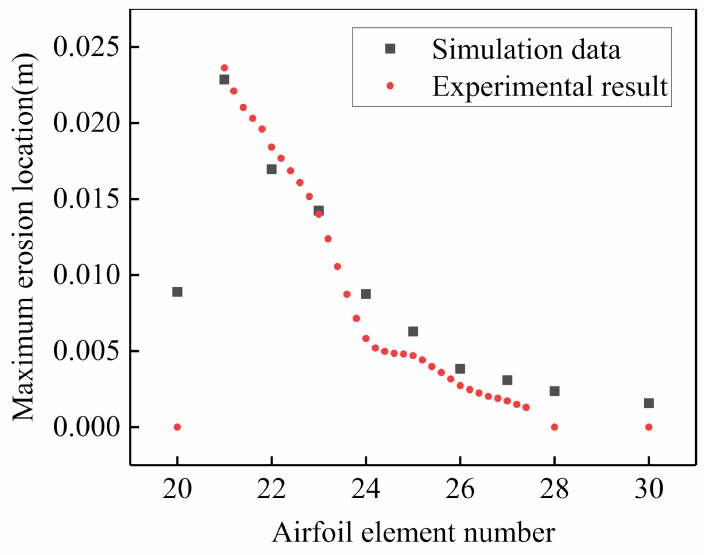
Figure 9. Comparison of the maximum erosion location of the simulation and the experiment.